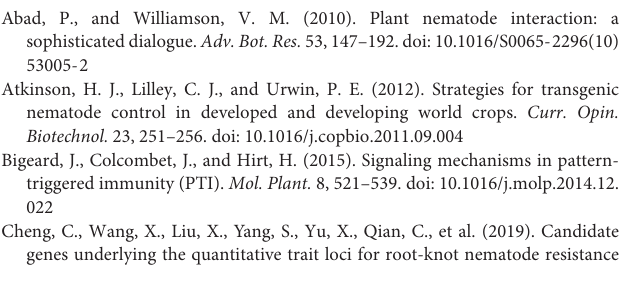
Supplementary Figure 1 | Relative expression level of selected hormone metabolism related genes in roots of Q24 and CM at 2, 3, 4, 5 dpi by qPCR. MAPK9 , mitogen-activated protein kinase 9; PAL , phenylalanine ammonia-lyase genes; TGA7 , bZIP transcription factor; GH3.6 , indole-3-acetic acid-amido synthetase GH3.6. Supplementary Figure 2 | The heat map showing the correlation between all root samples of CM and Q24 at 3 dpi and the control. The color represents the correlation coefficient between every two samples. The deeper the color, the greater the correlation coefficient. Supplementary Figure 3 | The FPKM of 4 genes related hormone metabolism in transcriptomic data. MAPK9 , mitogen-activated protein kinase 9; PAL ,